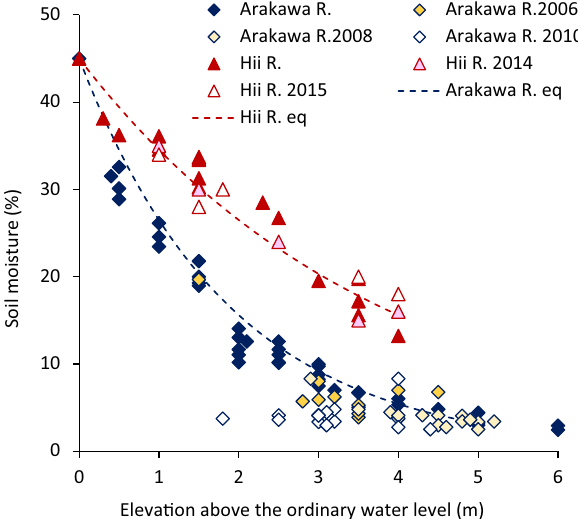
Figure 1. Relationship between elevation above ordinary water level and soil moisture. Data are from this study and previous studies from 2006 to 2015 22,30,56,66